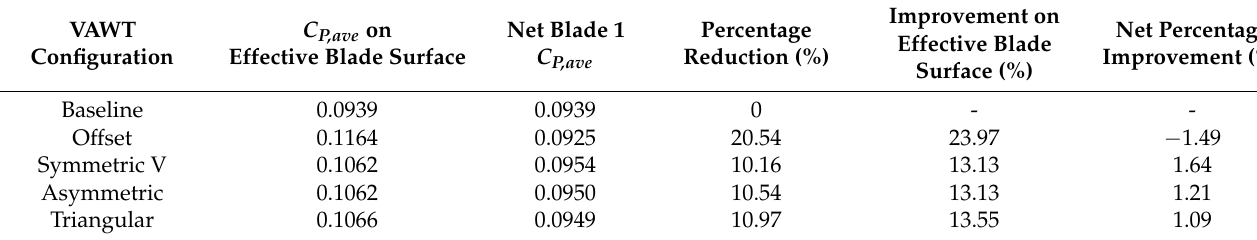
Table 6. Breakdown of Blade 1 C P in TSR